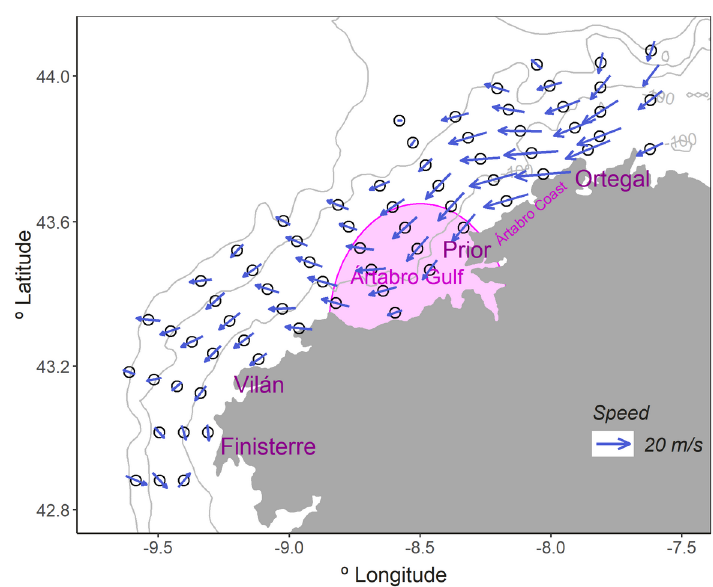
Figure 1. Distribution of the sampled stations (black circles). The pink-shaded area is the Artabro Gulf, an important spawning area for many commercial species. The main capes in the area are shown in magenta. Blue arrows are the geostrophic velocity of currents at each sampling station.